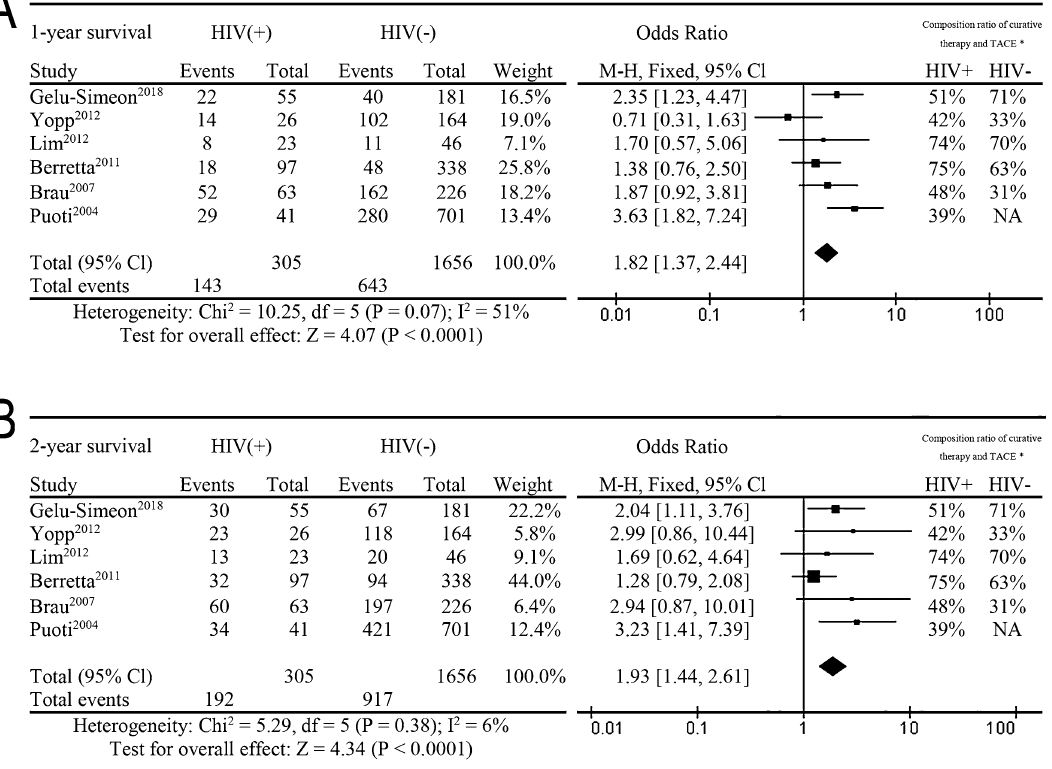
Figure 2. The overall meta-analysis comparing the overall survival between HCC patients with HIV and without HIV. * Composition ratio of curative therapy and TACE: (Curative therapy + TACE)/ the total number of HIV+ patients or HIV− patients. ( A ) Based on one year survival rate. ( B ) Based on two year survival